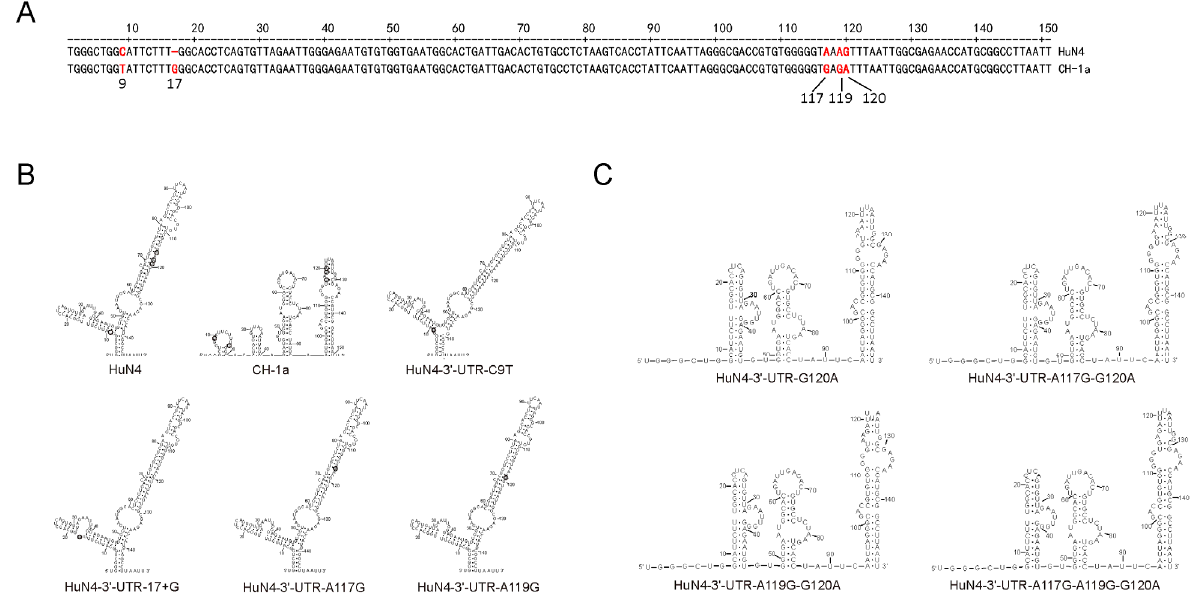
Figure 3. Predicted 3 ′ -UTR secondary structures of parental HuN4 and mutant viruses. ( A ) The alignment of 3 ′ -UTR between HP-PRRSV HuN4 strain and classical PRRSV CH-1a strain. The 3 ′ -UTR d iff erential nucleotides in HuN4 and CH-1a were marked in red. ( B ) The 3 ′ -UTR secondary structures of HuN4, CH-1a, HuN4-3 ′ -UTR-C9T, HuN4-3 ′ -UTR-17+G, HuN4-3 ′ -UTR-A117G and HuN4-3 ′ -UTR-A119G were predicted by mFold method. Different nucleotides between HuN4-3 ′ -UTR and CH-1a-3 ′ -UTR were depicted by hollow round. Mutant nucleotides in the 3 ′ -UTR of HuN4-3 ′ -UTR-C9T, HuN4-3 ′ -UTR-17+G, HuN4-3 ′ -UTR-A117G and HuN4-3 ′ -UTR-A119G were depicted by gray round. ( C ) The 3 ′ -UTR secondary structures of HuN4-3 ′ -UTR-G120A, HuN4-3 ′ -UTR-117+120, HuN4-3 ′ -UTR-119+120 and HuN4-3 ′ -UTR-117+119+120.